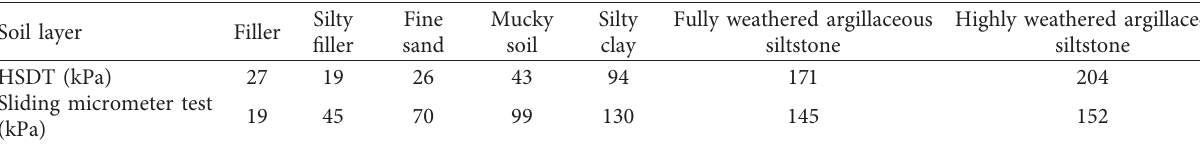
Table 6: Average values of pile side resistance in different soil layers at the hard rock bearing stratum site.